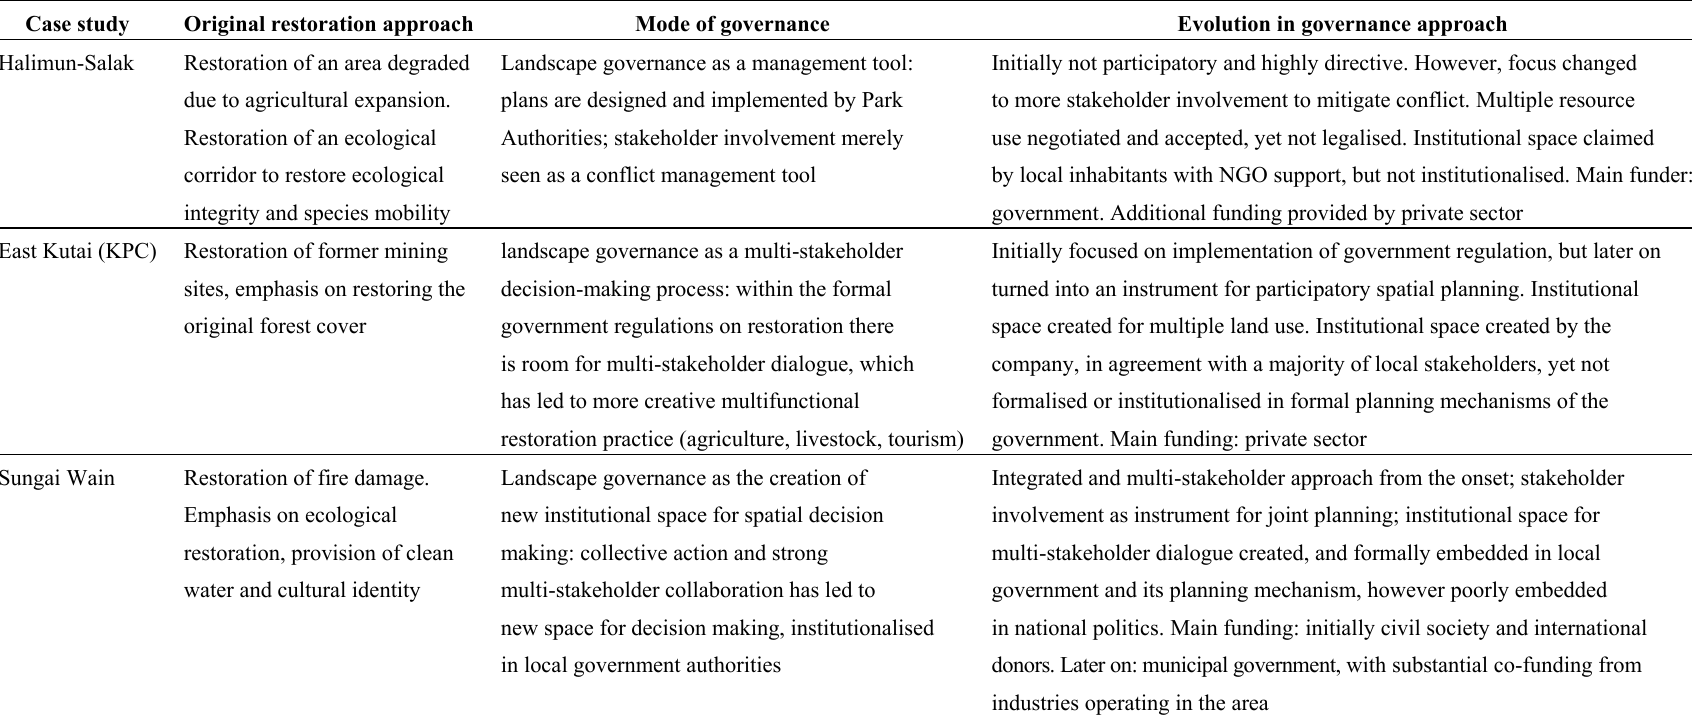
Table 2. Comparative overview of the governance process of three cases of forest landscape restoration in